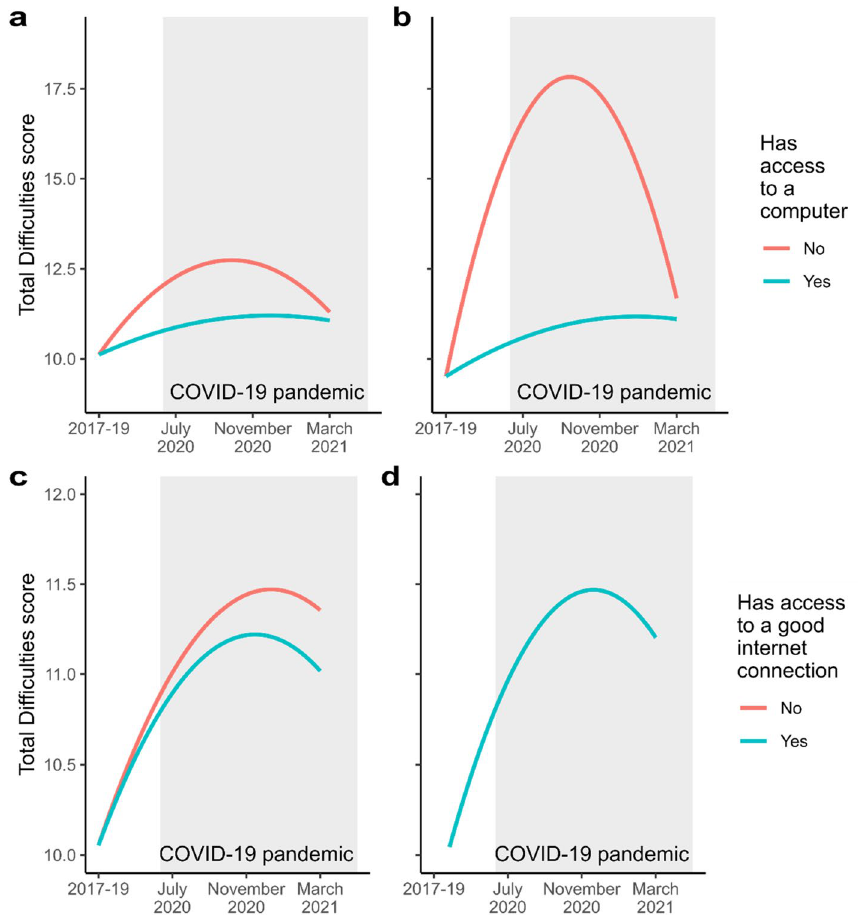
Figure 3. Latent growth curve models of youth SDQ Total Difficulties scores, grouped by each of the two digital inclusion criteria. ( a ) and ( b ) show the models grouped by access to a computer—( a ) does not include sociodemographic control variables, but does have survey weights applied, while ( b ) does include the control variables but does not have weights applied (since this process is not robust given the small size of the digitally excluded group). The same apply for ( c ) and ( d ), which portray the models grouped by access to a good internet connection—in the latter, the modelled trajectories are